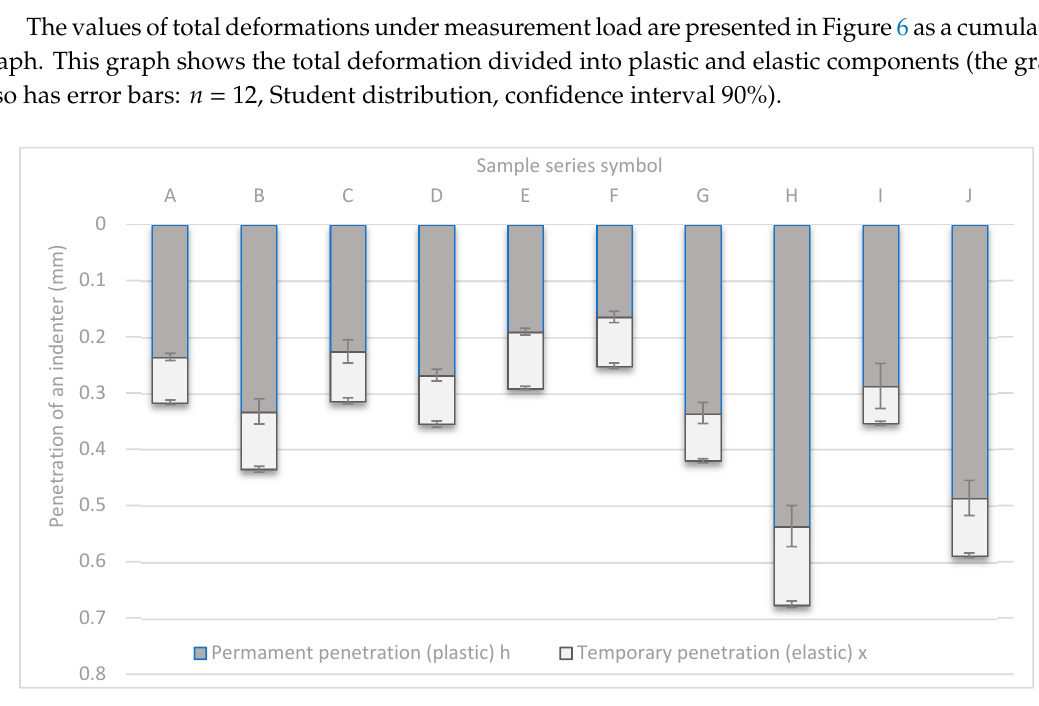
Figure 6. Total deformation of samples under load.